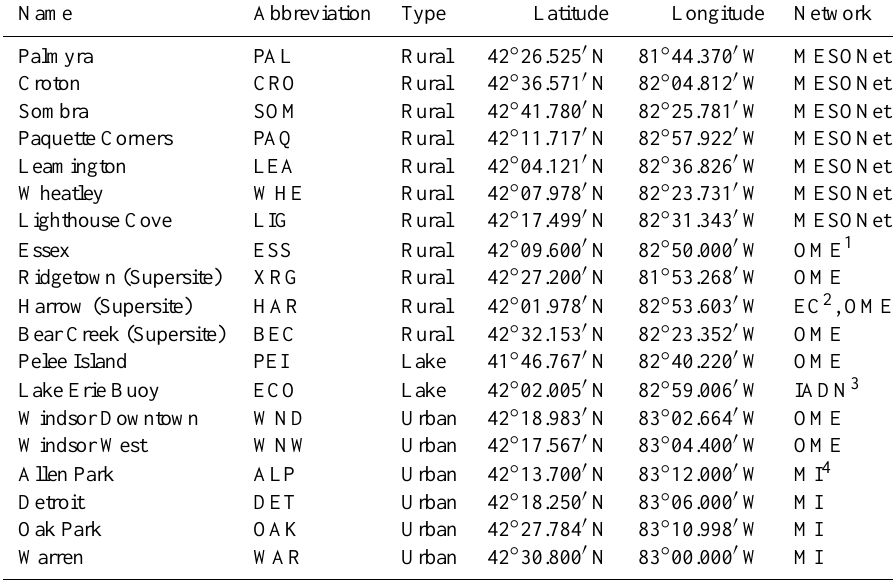
Table 1. List of sites used for ozone